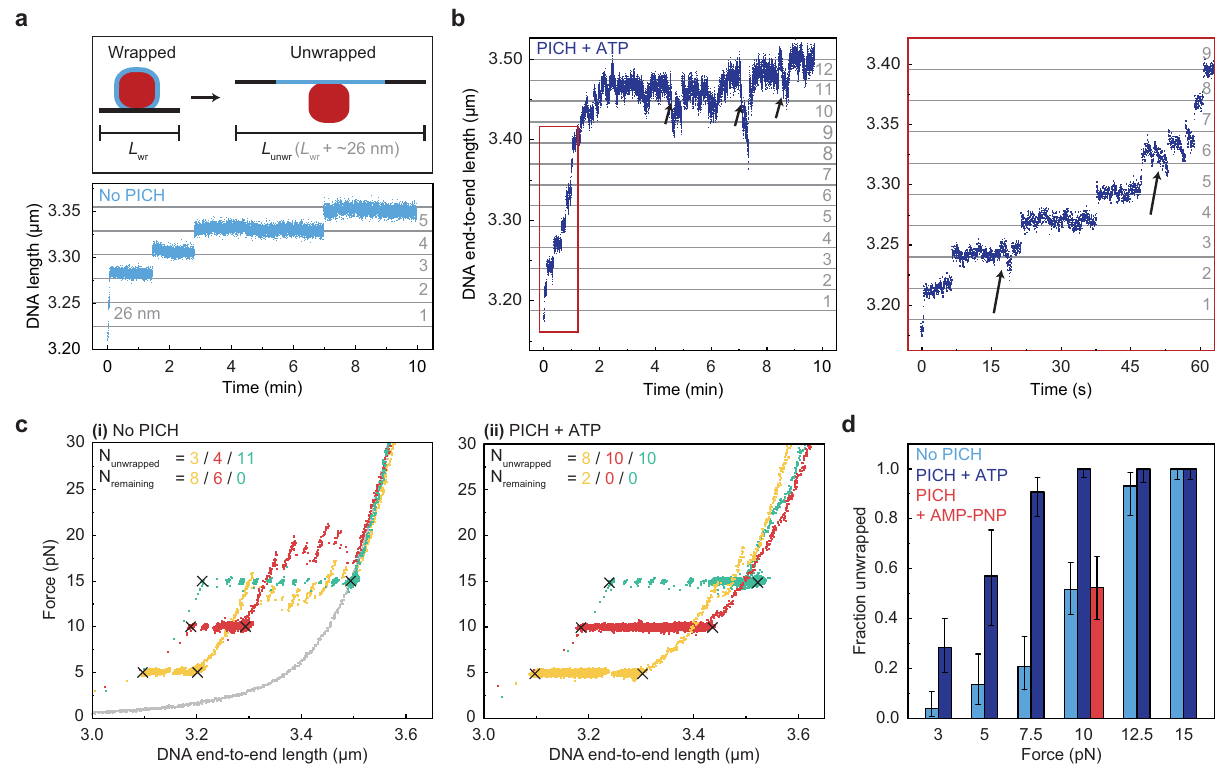
Fig. 2 | PICH facilitates tension-induced nucleosome unwrapping using ATP hydrolysis. a Top: Schematic representation of inner-turn nucleosome unwrap- ping,with DNA end-to-end length of the wrapped and unwrappedstatesas L wr and L unwr , respectively. The histone octamer, inner-turn DNA, and outer-turn DNA are depictedinred,lightblueandblack,respectively. Bottom: RepresentativeDistance- Time trace showing inner-turn nucleosome unwrapping events occurring over 10min at 10pN in the absence of PICH and ATP. Horizontal gray lines indicate 26nm steps. The number of observedunwrapping events isindicated onthe right. b Left: Representative Distance-Time trace of inner-turn nucleosome unwrapping occurringover10minat10pNinthepresenceofPICHandATP. Right :Azoom-inof the constant-force measurement shown on the left. Horizontal gray lines indicate 26nm steps. Black arrows indicate ATP-dependent loop-extrusion by PICH. The numberofobservedunwrappingeventsisindicatedontherightsideofeachpanel.